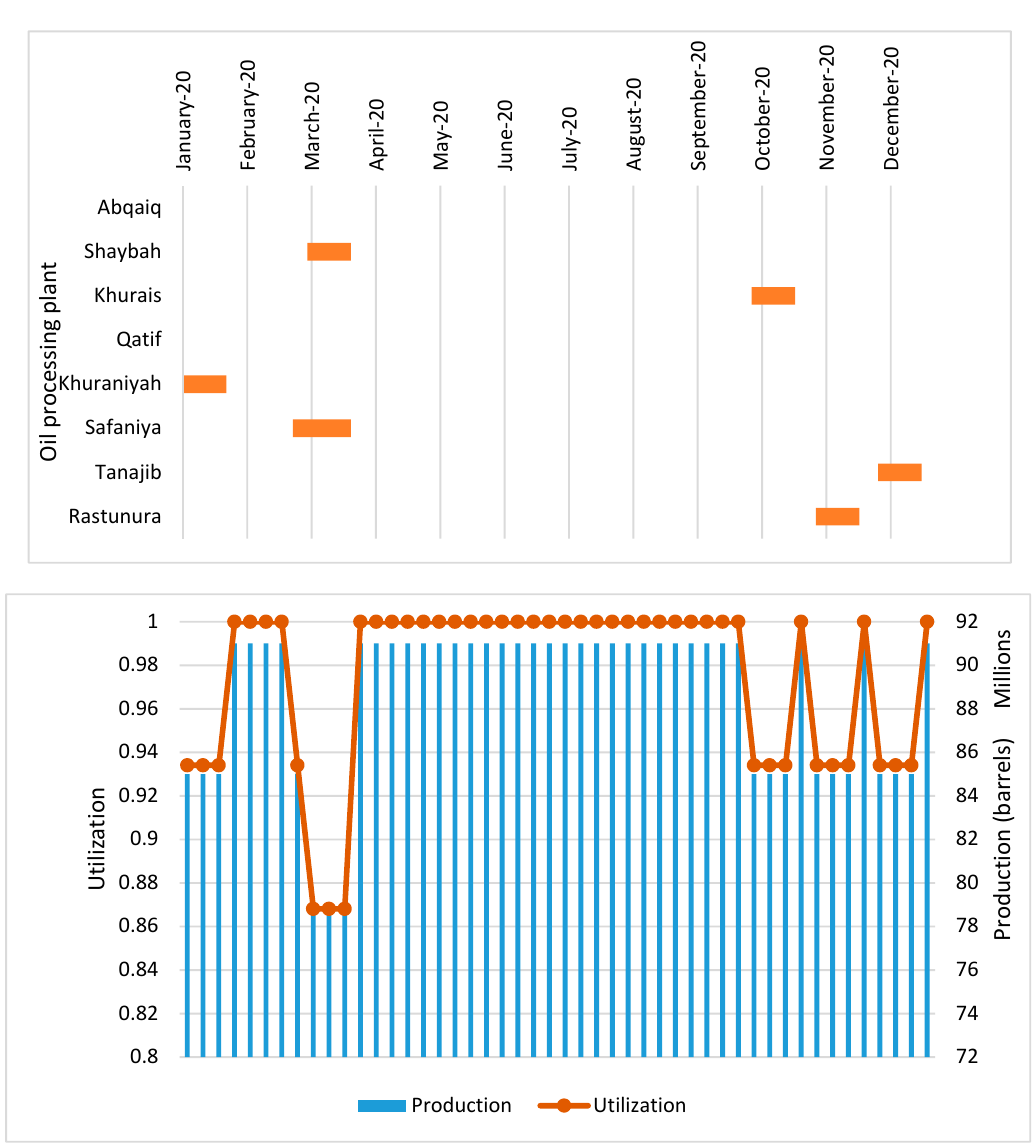
Figure 6. Oil processing plants maintenance scheduling, production, and utilization (year 1). Figure 7 indicates the fractionation plant storage capacities and inventory levels fluctuations across the planning horizon. Production and maintenance are carried out on a weekly basis, while demand is on a monthly basis. As a result, the inventory level accumulated over the first four weeks of a month, then decreased as demand occurred at the end of the last week of a